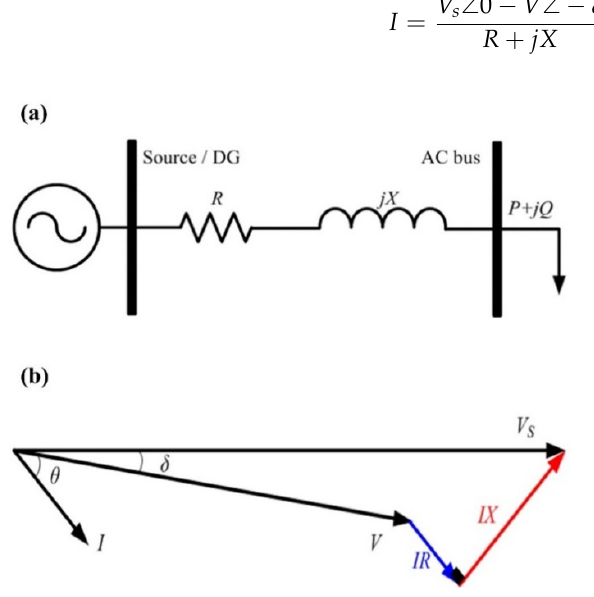
Figure 2. ( a ) Power flow model of a line and ( b ) its represented phasor diagram.